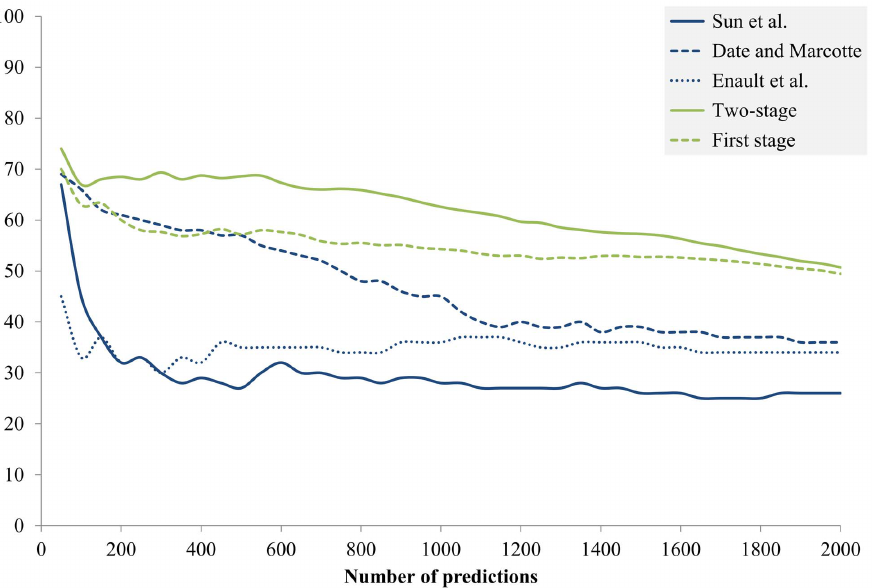
Figure 4.Comparison of the proposed two-stage approach to three PP-based techniques. The y -axis is the ratio of correct predictions predicted in the top n predictions ( x -axis).